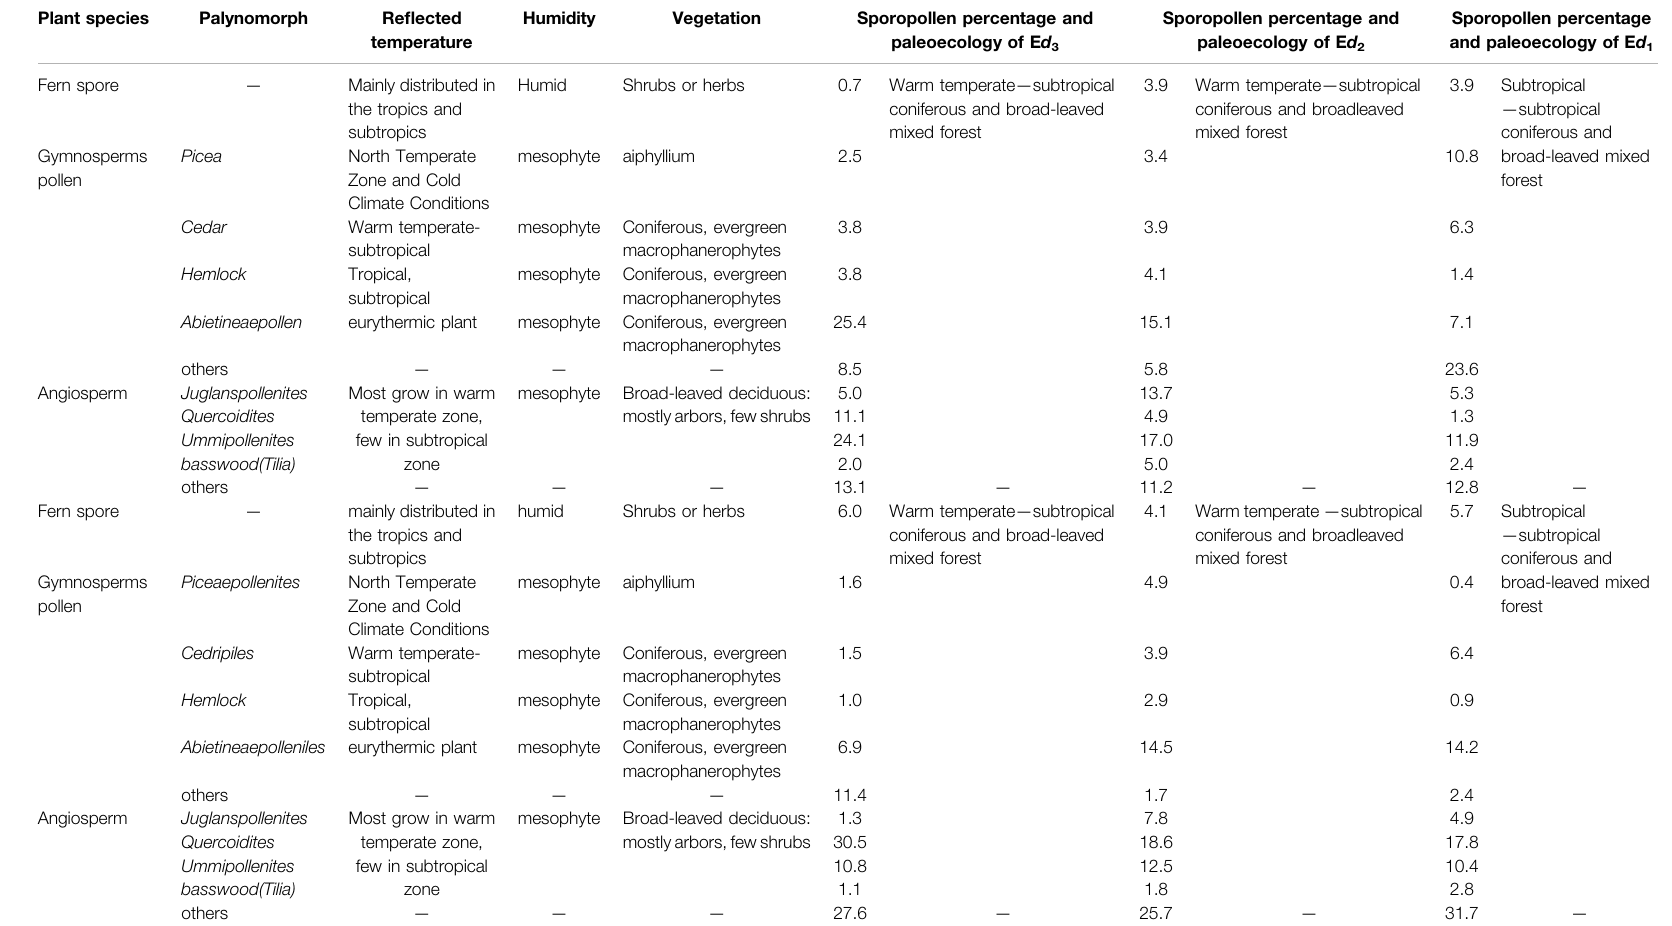
TABLE 3 | Paleoclimate and paleo-vegetation re fl ected by the pollen assemblage of the Dongying Formation in Nanpu Sag (Some of the data were cited from Zhang, 2010). Plant